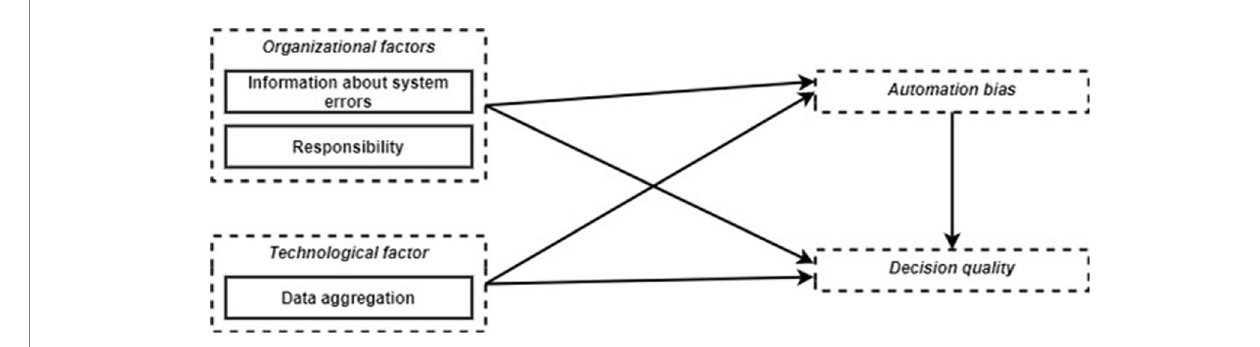
FIGURE 1 Proposed research